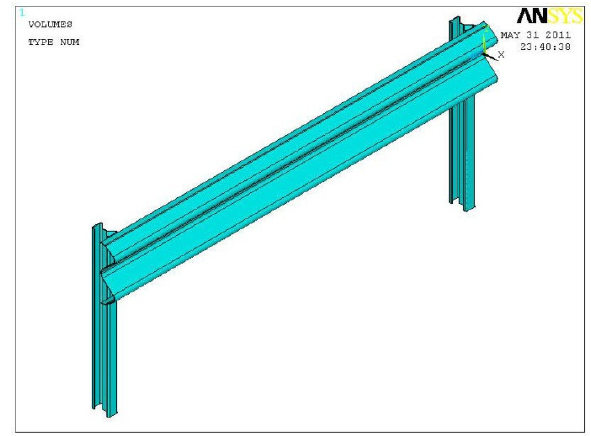
Fig. 7. The computer model of the guardrail part (our research)